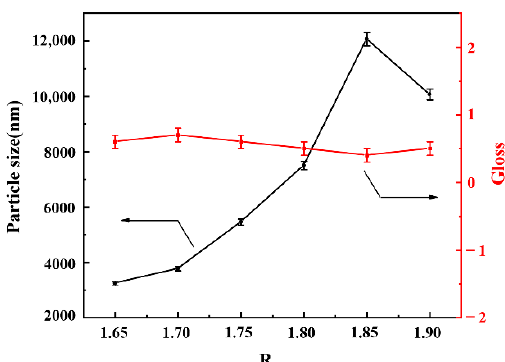
Figure 6. The particle sizes of WPU-R dispersions and gloss of WPU-R films with different R values.